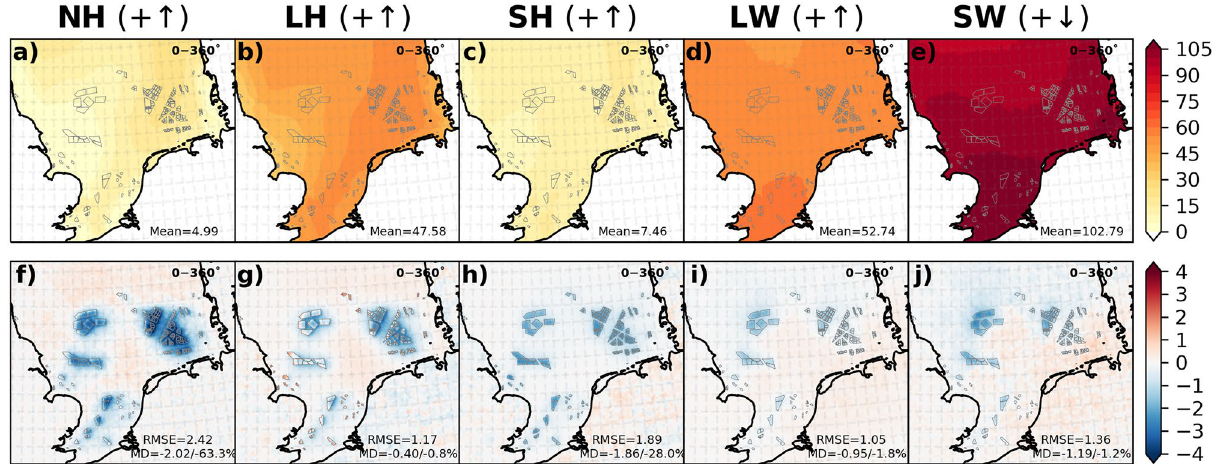
Figure 10. Annual mean values of the CCLM and differences between the CCLM_WF and CCLM for ( a , f ) net heat (NH) flux, ( b , g ) latent heat (LH) flux, ( c , h ) sensible heat (SH) flux, ( d , i ) net upwelling longwave (LW), and ( e , j ) net shortwave downwelling (SW) radiations outside and inside the wind farms for the prevailing wind directions of 0–360° in 2008–2017. Root mean square errors (RMSE) and mean differences (MD) over the wind farm areas in 2008–2017 are given in the legend. This figure was created with Matplotlib (Hunter, J. D., Matplotlib: a 2D graphics environment. Computing in Science and Engineering 9, 2007) and Cartopy (Met office, Cartopy: a cartographic python library with a matplotlib interface. Exeter, Devon, https:// scito ols. org. uk/ carto py,